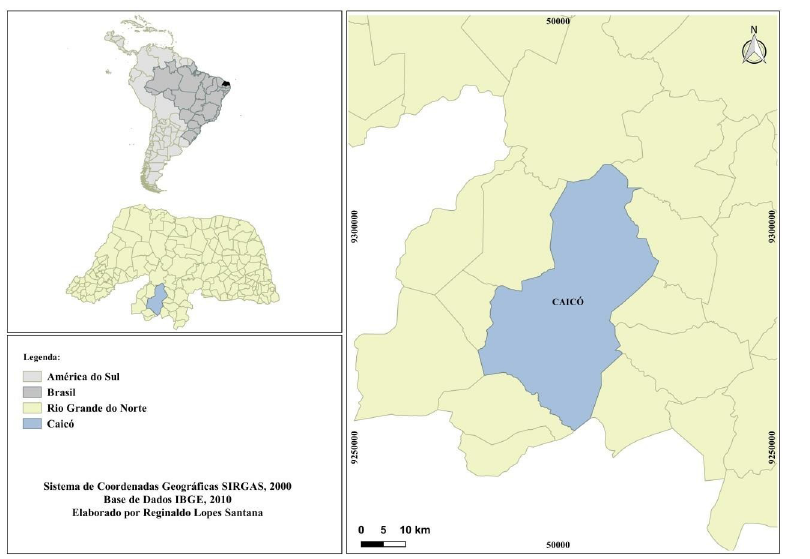
Fig 1. Geographic location of the municipality of Caico´, state of Rio Grande do